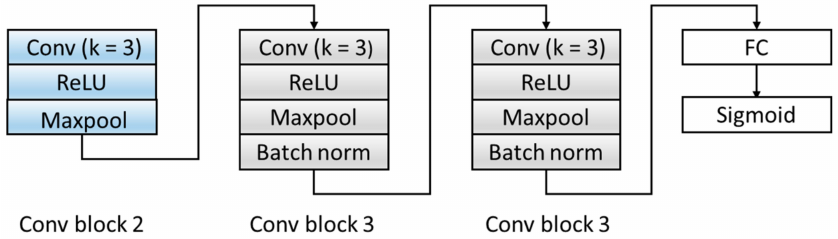
Figure 6. The structure of the domain discriminator block. ReLU: Rectified Linear Unit. FC: fully connect. Table 4. A summary table of the domain discriminator (D) block. FC: fully connect